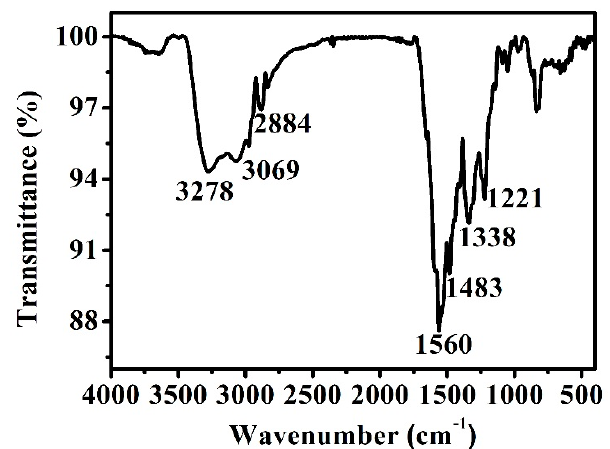
Figure 4. Fourier transform infrared (FTIR) spectrum of the g-CQDs (V (EDA) = 4 mL, T = 180 °C, D r = 12 h).